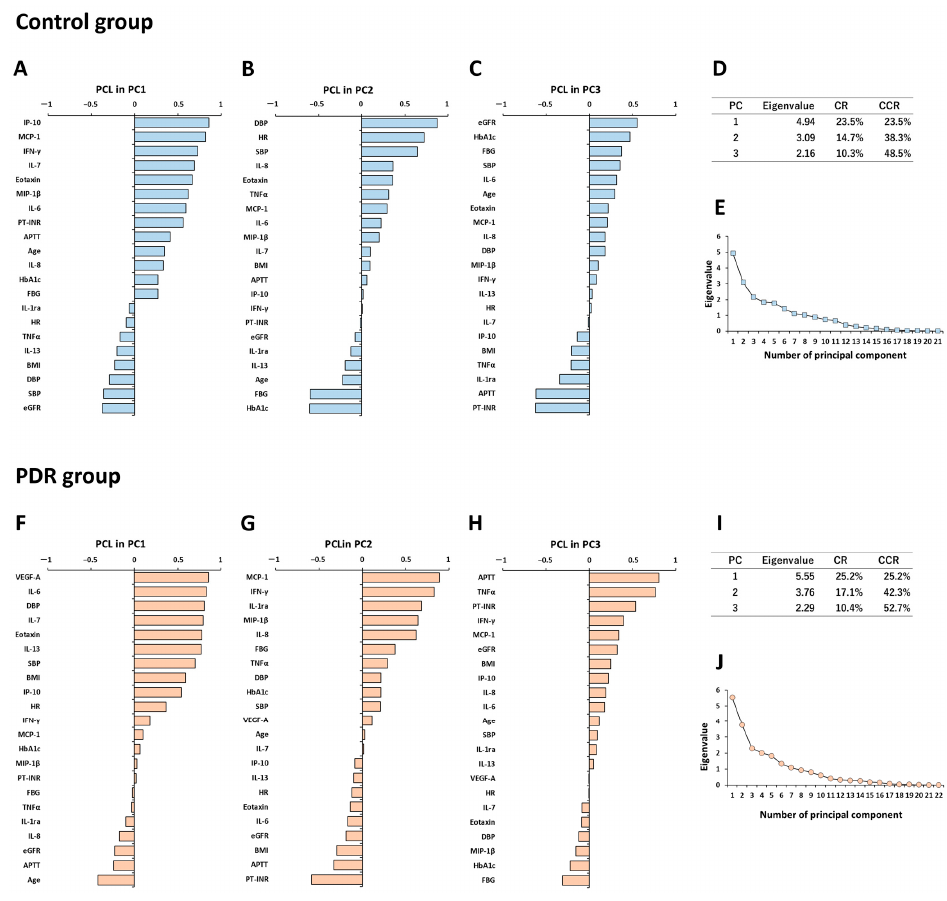
Figure 2. Principal component analysis showing expression patterns of systemic factors and vitreous fluid cytokines in PDR patients and controls. Expression patterns of systemic factors and vitreous fluid cytokines in PCA are shown in ( A – E ) controls and ( F – J ) PDR patients. In PCA of control group, PCLs of ( A ) PC1, ( B ) PC2 and ( C ) PC3 are shown. ( D ) eigenvalue, CR and CCR, and ( E ) plots of eigenvalue of all PCs are presented. In PDR group, PCLs of ( F ) PC1, ( G ) PC2 and ( H ) PC3 are shown. ( I ) eigenvalue, CR and CCR, and ( J ) plots of eigenvalue of all PCs are presented. CCR; cumulative contribution ratio, CR; contribution ratio, PC; principal component, PCA; principal component analysis, PCL; principal component loading, PC1; first principal component, PC2; second principal component, PC3; third principal